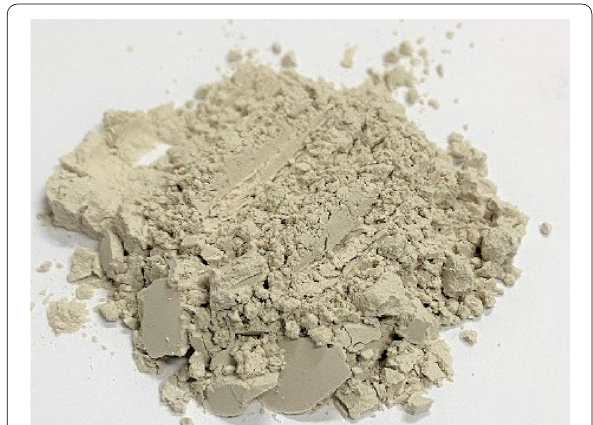
Fig. 1 Picture of concave bumpy clay powder.